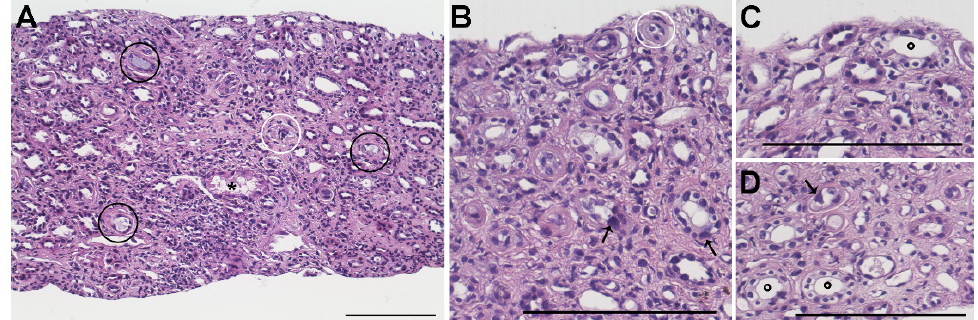
Figure 1. Chemotherapy-induced nephrotoxicity. ( A ) Hematoxylin and Eosin staining shows tubular damage in a kidney biopsy of a patient following treatment with a cocktail of cisplatin, carboplatin, etoposide, cyclophosphamide, and vincristine. ( B – D ) Higher magnification of biopsy shown in ( A ). Black circles indicate distal tubular casts. White circles indicate luminal cellular debris. * indicates proximal tubule injury. ◦ indicates regenerative nuclear atypia. Arrows indicate karyomegaly. Bars 100 µm .